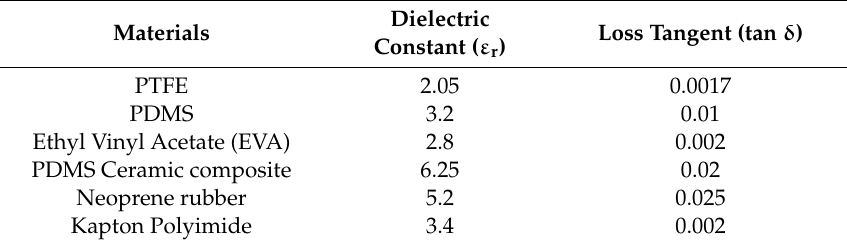
Table 3. Properties of the substrate [96,176]. Table 4. Comparison of different flexible materials [177].